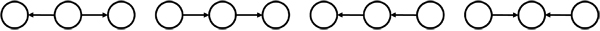
Structures with three nodes and two edges